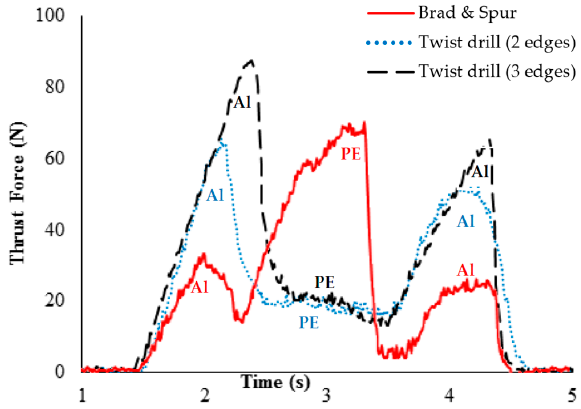
Figure 5. Profile of thrust force versus time for special drill bits for cutting speed 24 m/min and feed 0.05 mm/rev.